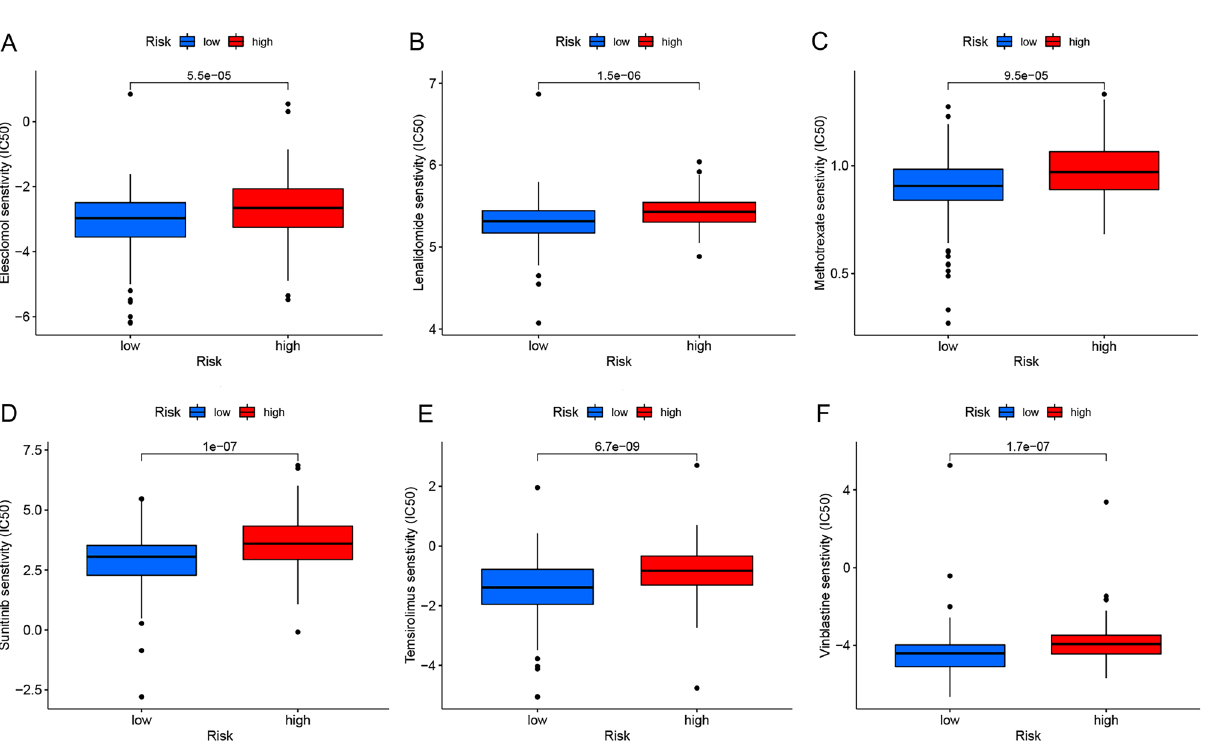
Figure 14. ( A – F ) Distribution of drug sensitivity between the two-risk